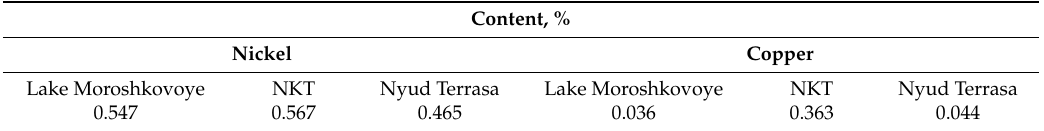
Table 1. Nickel and copper content in the ore samples.